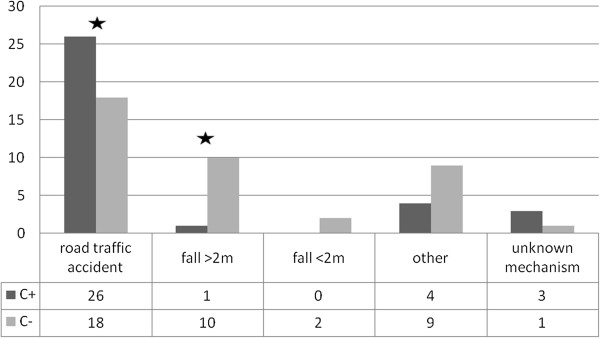
Trauma mechanisms, p < 0.05.